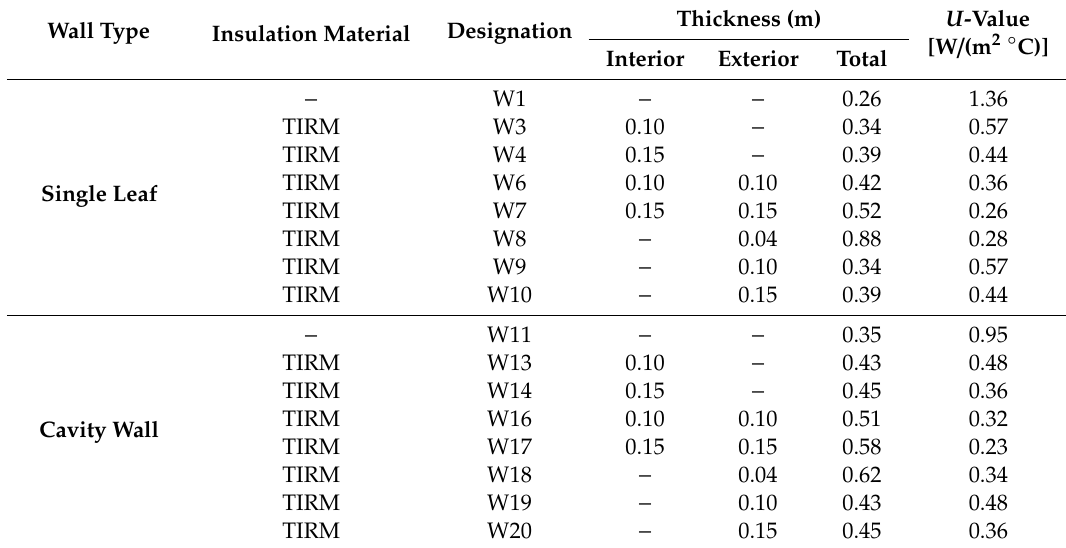
Table 1. Label, thickness and U -Value of the wall solutions analysed.